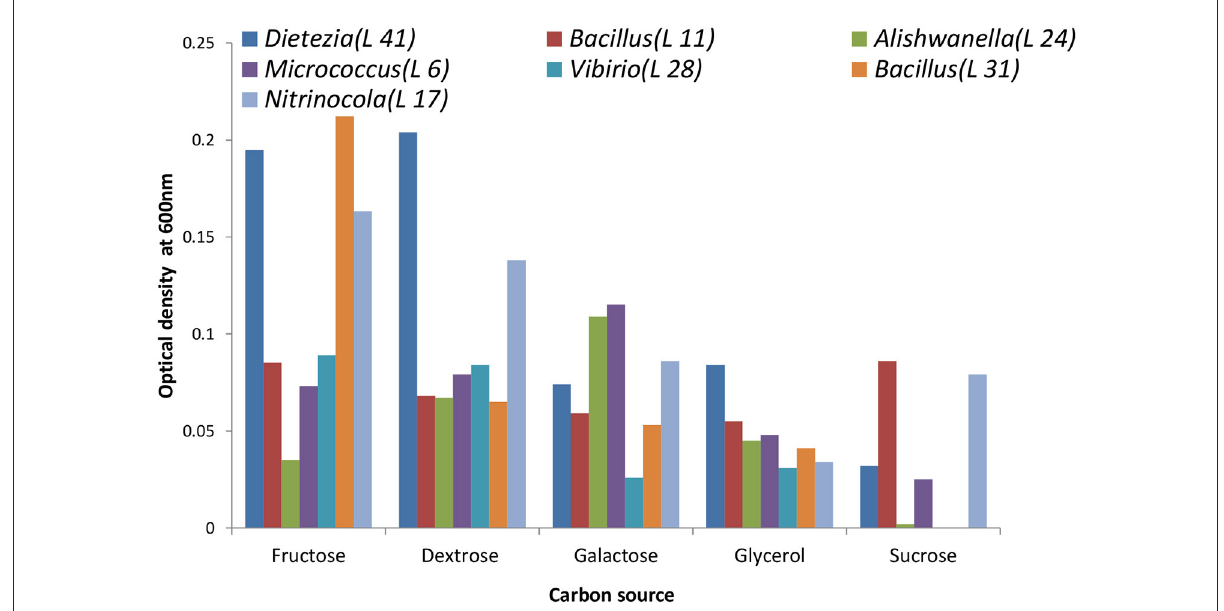
FIGURE1 Utilization of different carbon sources by the isolates. Dextrose proved to be the most suitable one for stable